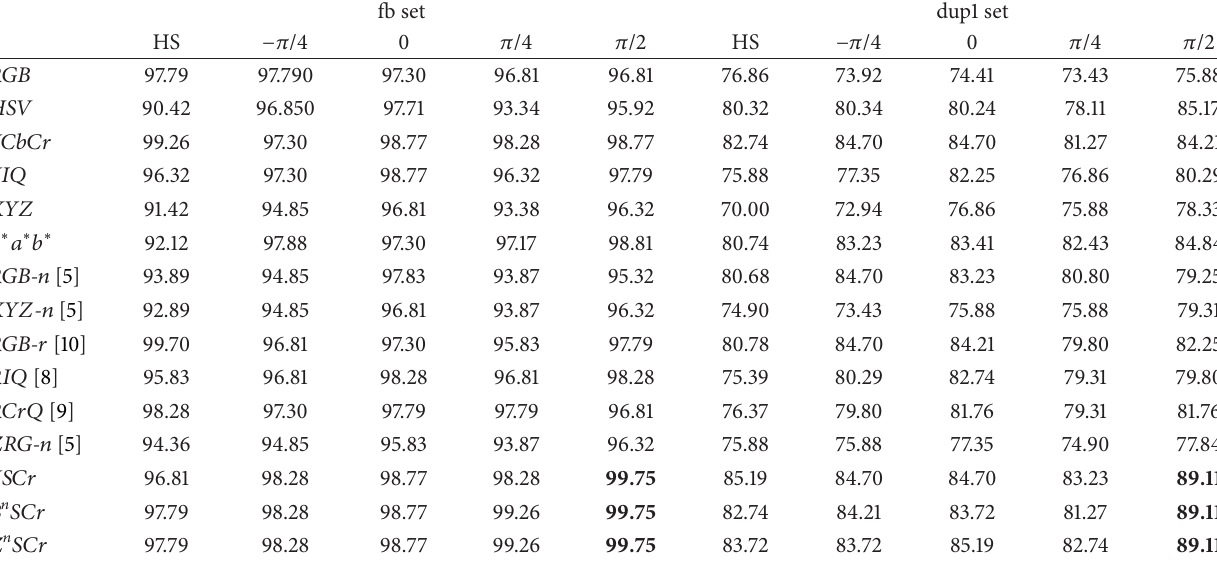
Table 6: Performance comparison in different hybrid color spaces of LCSPT-ELM face recognition algorithm: the color FERET